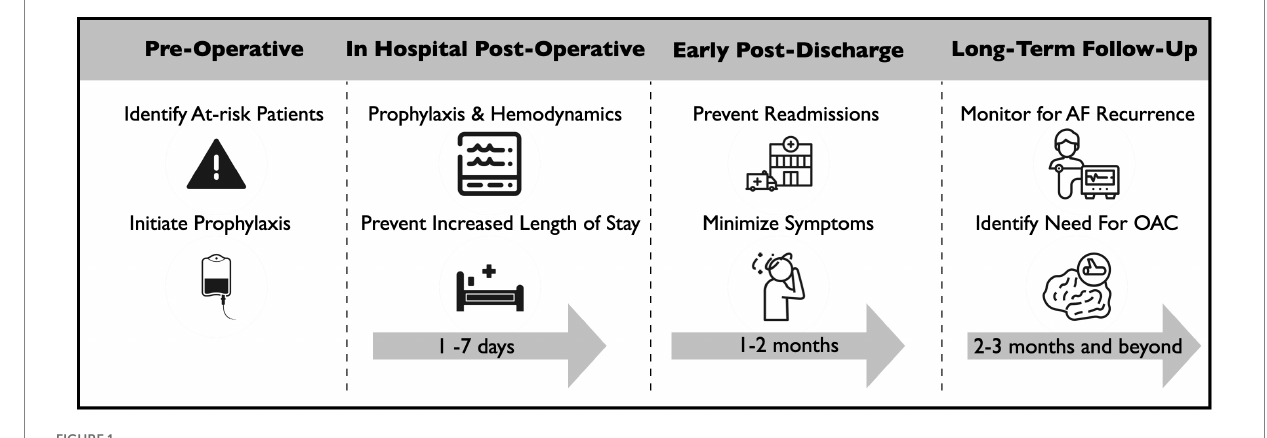
FIGURE 1 Management challenges for patients with POAF after cardiac